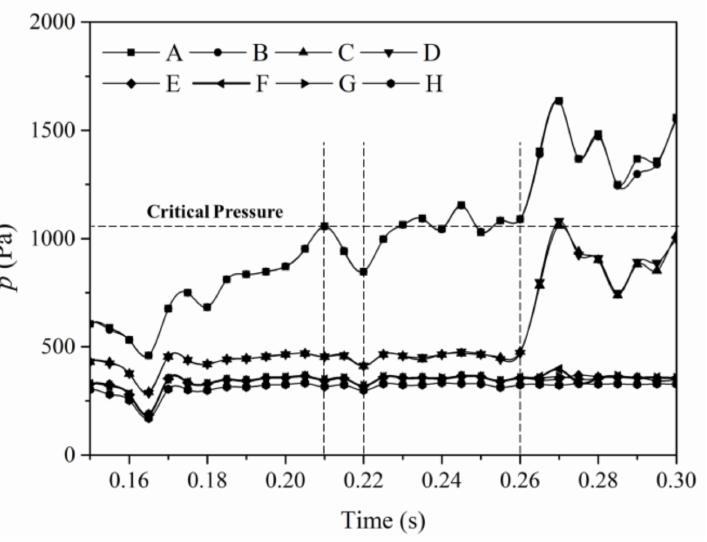
Figure 5. Change of the pressure in the water side of water–oil interface when remaining oil starts to move in case II (continuous